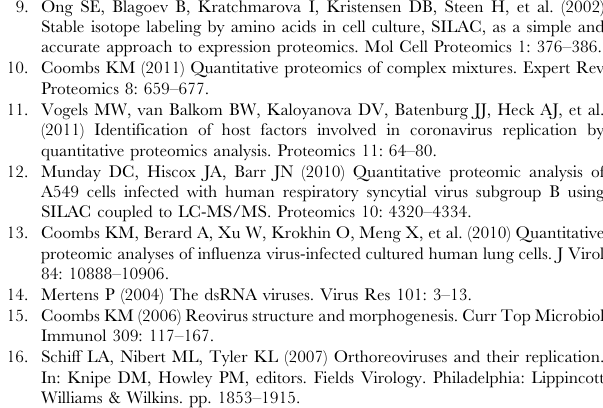
Figure S1 DAVID analysis of up (a, b) or down regulated (c, d) proteins using average z-scores from all three biological replicates. Metabolic and biological functions are shown that are enriched from the differentially regulated protein lists at 95, 99, and 99.9% confidence cutoffs (indicated by blue, red and green bars,